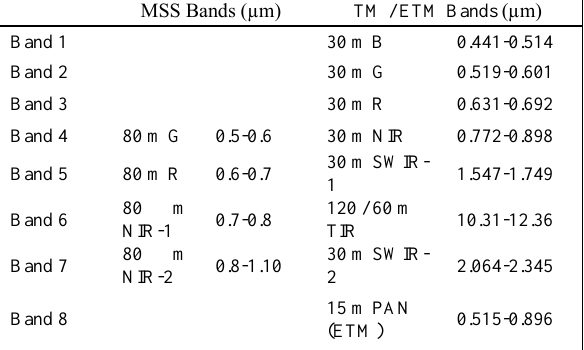
Figure 2. CORINE Land Cover 2000 and 2012